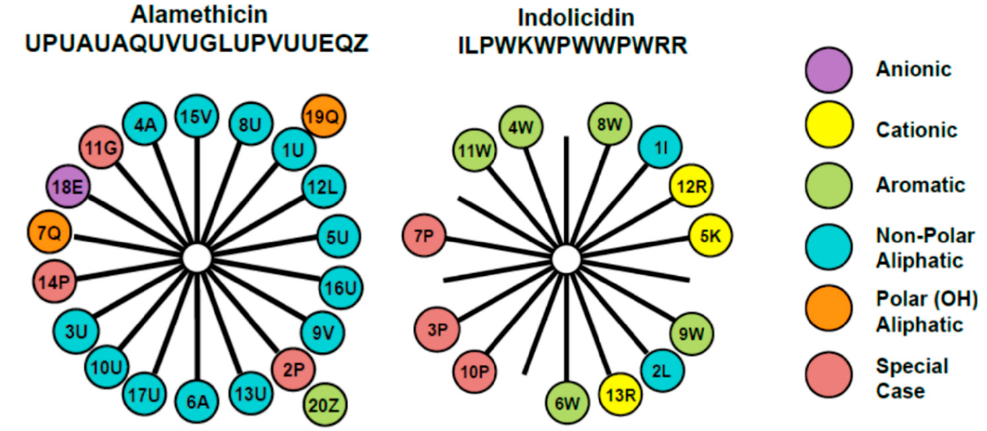
Figure 1. Helical wheel diagrams for alamethicin and indolicidin [7] explored in this study. This diagram provides a projection of amino acids perpendicular to the helix long axis assuming that the peptide exists in an α -helical secondary structure. Since the α -helix contains 3.6 residues per turn, adjacent residues on the peptide are separated by 100° on the helical wheel. The number represents the position of the amino acid in the peptide chain and the letter denotes the commonly accepted single letter notation used to designate amino acids. The uncommon amino acids α -aminoisobutyric acid and L -phenylalaninol in alamethicin’s amino acid sequence are represented by U and Z, respec- tively. These diagrams reveal differences in the placement of charged amino acid residues, as well as hydrophobic and polar side chains.